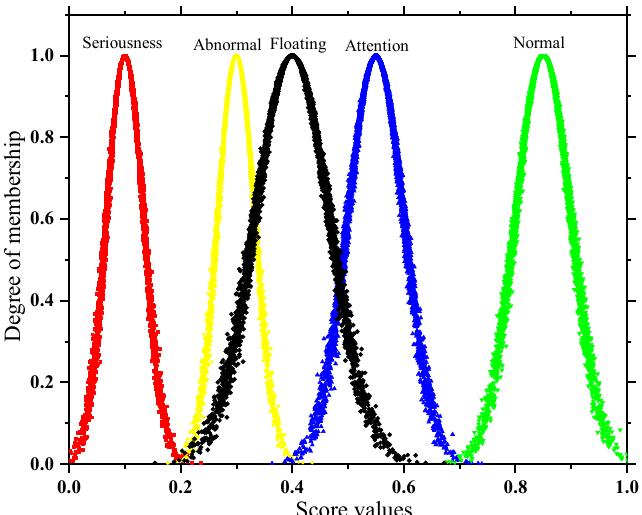
Figure 6. The degree of overlap between the floating cloud and the state cloud.